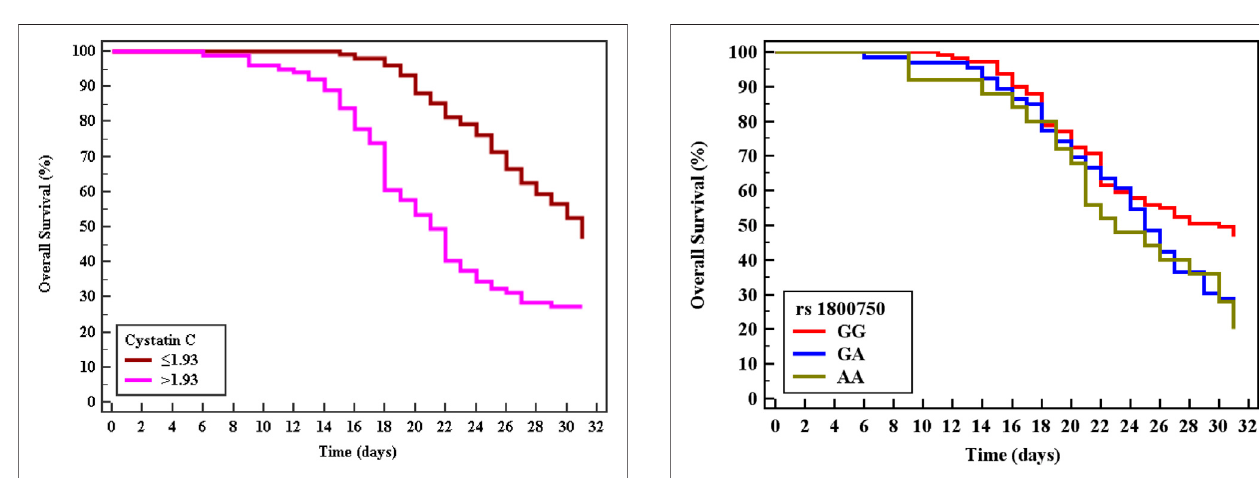
FIGURE 3 | Kaplan-Meier survival curve for Overall Survival with TNF- α (rs1800750) in total patients (No. (cid:1)